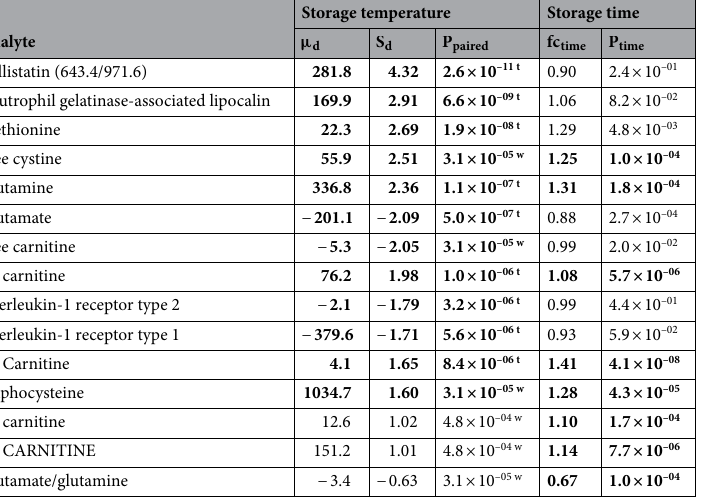
Table 2. Analytes most affected (cells highlighted with bold) by storage temperature defined as | S d | > 1.5 or by storage time in different temperatures defined as storage time associated with log 2 ( fc bm ) at a Bonferroni corrected significance threshold of p < 2.6 × 10 –4 . fc bm is the ratio of analyte levels for the paired samples at − 80 °C and − 20 °C, µ d is the mean of the difference between paired − 80 °C and − 20 °C samples, S d is the score for difference between paired − 80 °C and − 20 °C samples, S d = µ d /σ d , where σ d is the standard deviation of the difference between paired − 80 °C and − 20 °C samples, P paired is the paired t-test or Wilcoxon signed rank test p-value for the difference between − 80 and − 20 °C samples, fc time is the linear model estimate for the fold change per 1 year of storage, P time is the linear model p-value for the fc time estimate, t paired t-test, w paired Wilcoxon signed rank test.